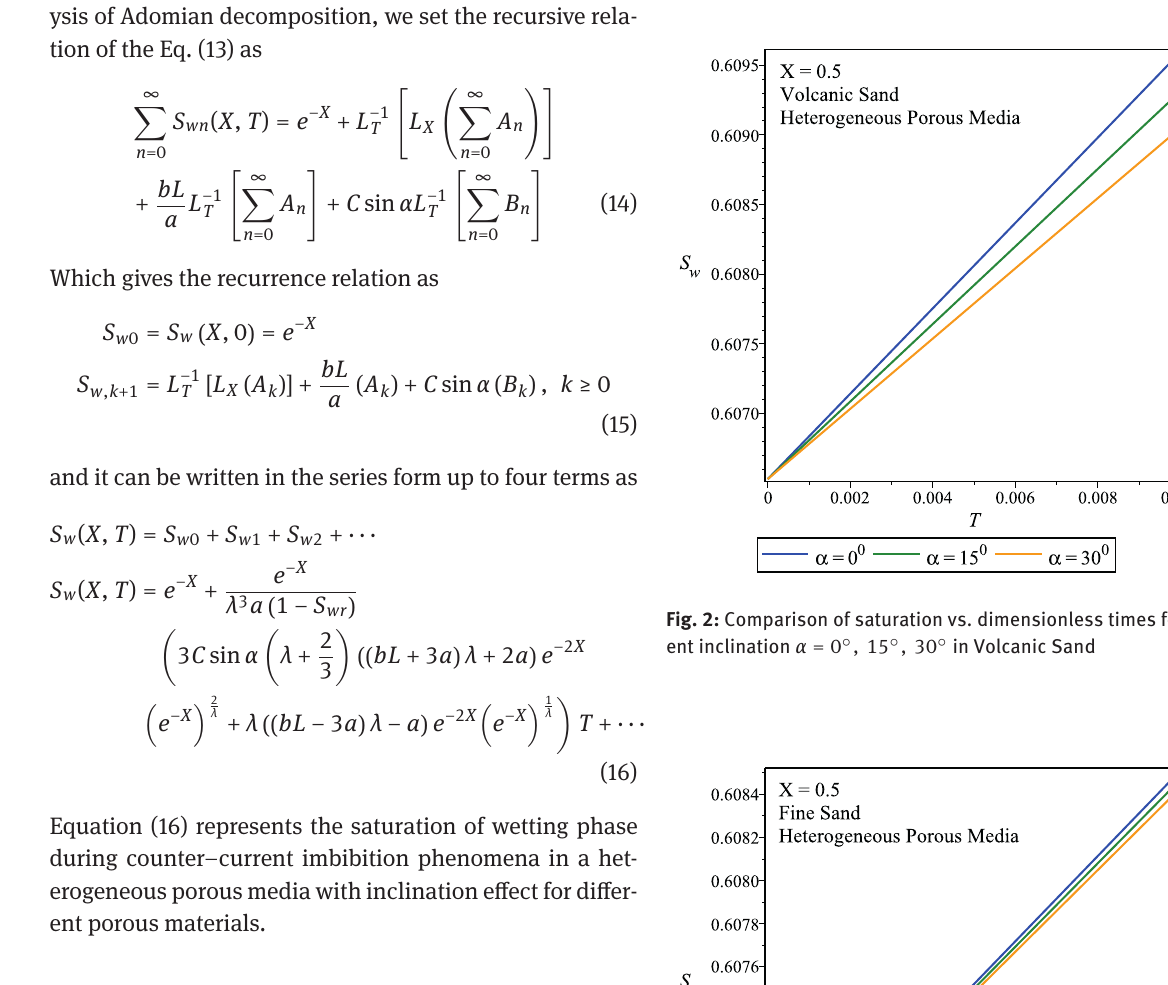
Table 1: Model parameters used in simulation Property